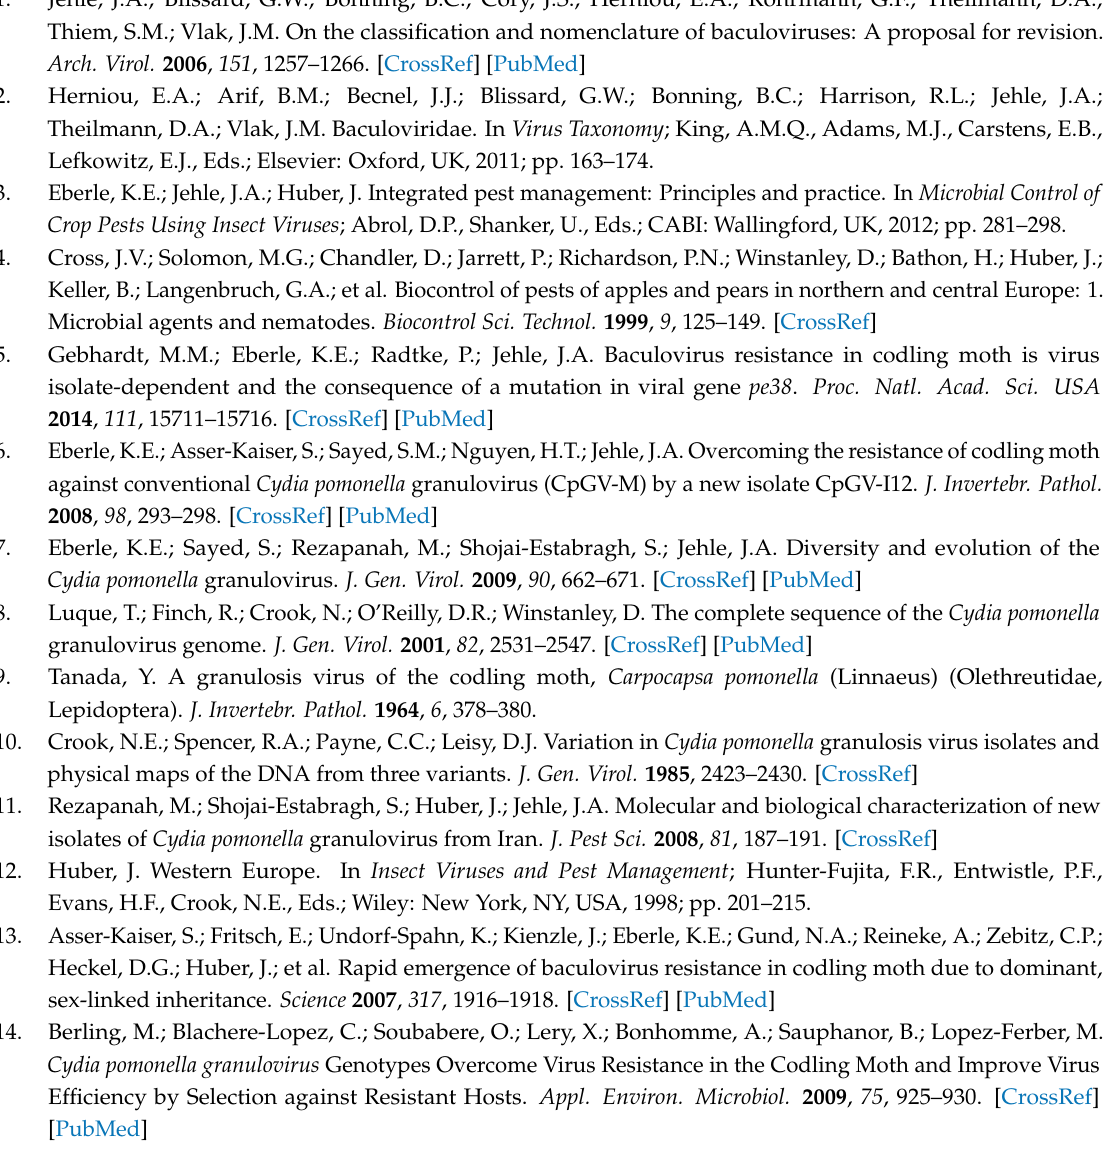
Table S1: Open reading frames (ORFs) and their positions within isolates of the Cydia pomonella granulovirus, Table S2: CpGV dispersed repeats (DR) of CpGV-M as found in CpGV-M1, -I12, -E2, -S and -I07, Table S3: Repeats of the CpGV